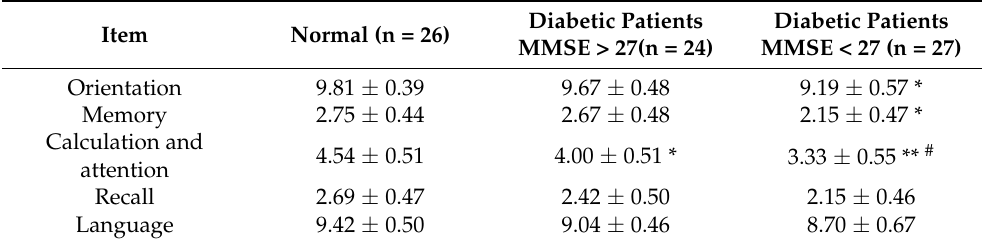
Table 1. MMSE scores of the diabetic patients and the normal people.